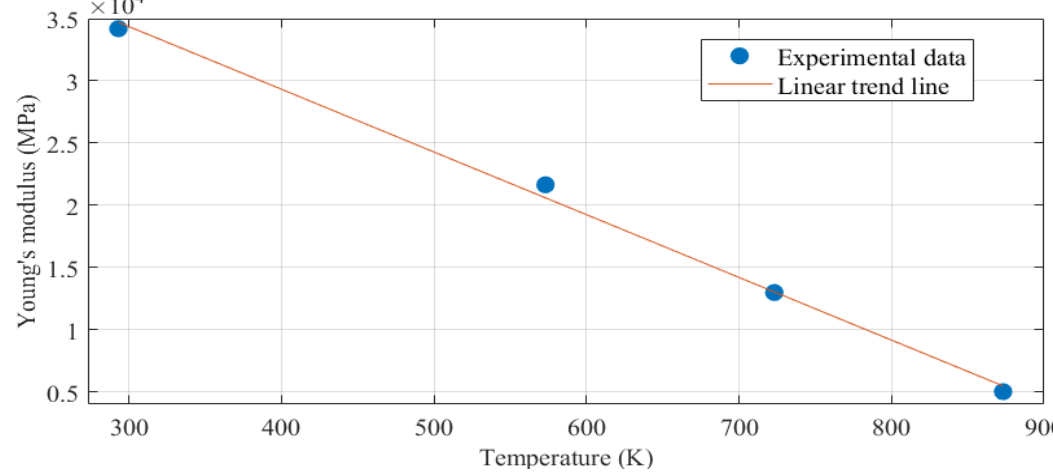
Figure 1. Relation between Young's modulus and